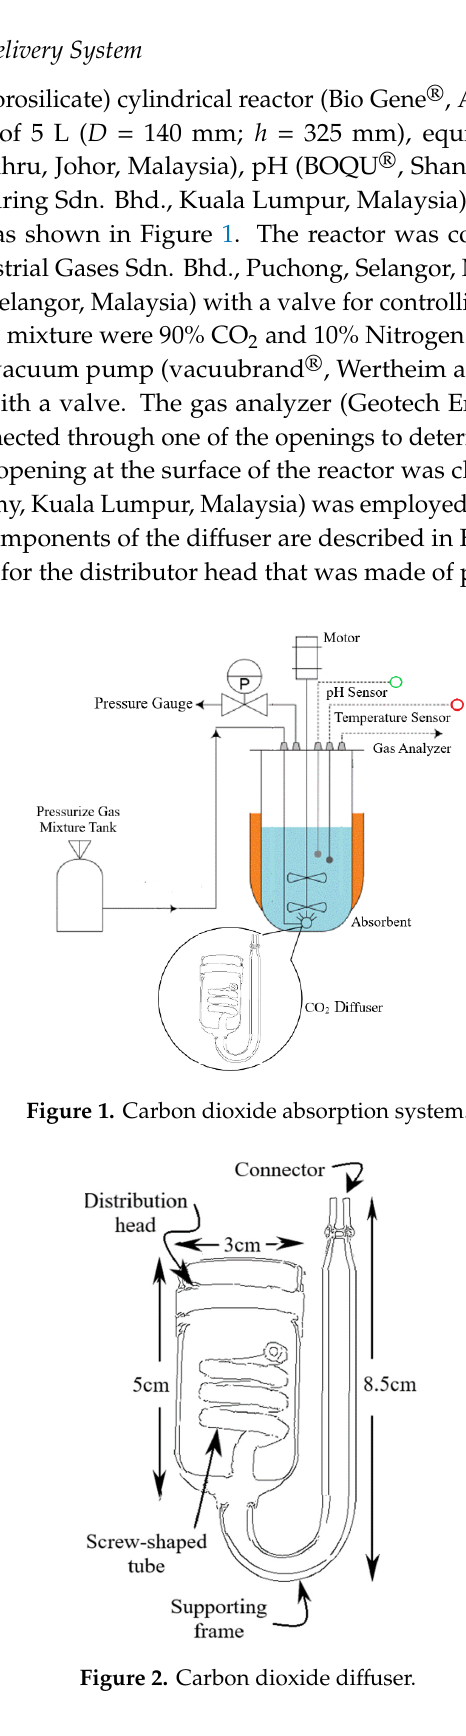
Figure 2. Carbon dioxide diffuser.